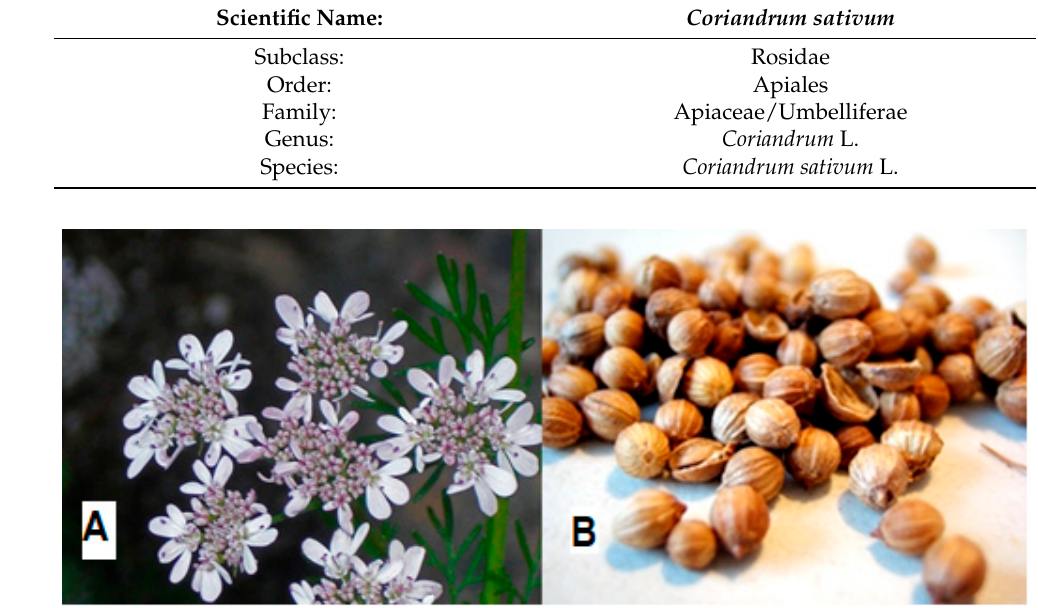
Table 1. The taxonomical classification of C. sativum is as follows: